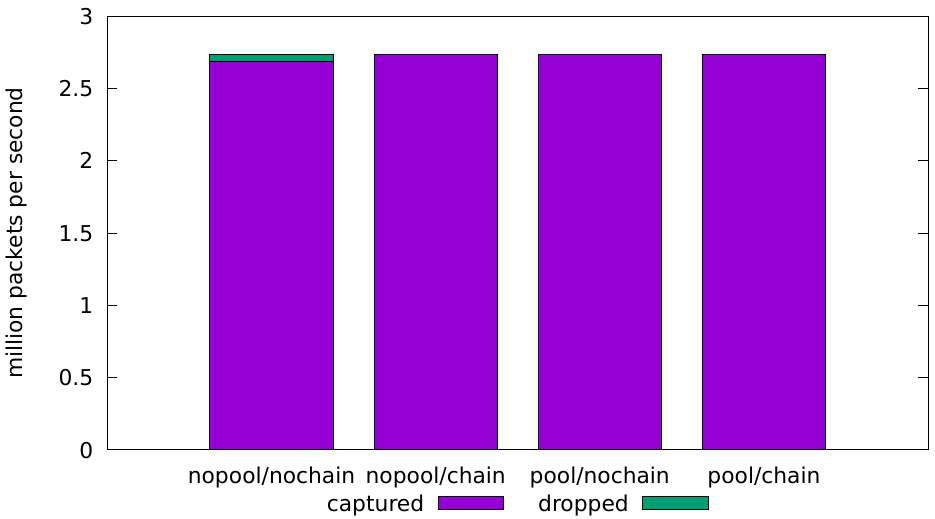
Figure 6. Evaluation on real-traffic replayed at 10 Gb/s from a pcap file. Application is run with SOURCE and SINK operators